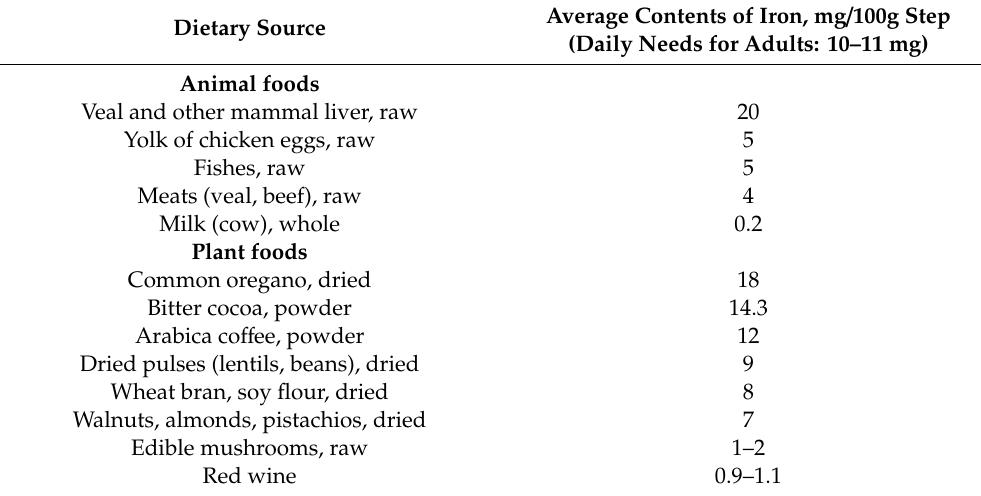
Table 1. Highest natural dietary sources of iron in decreasing